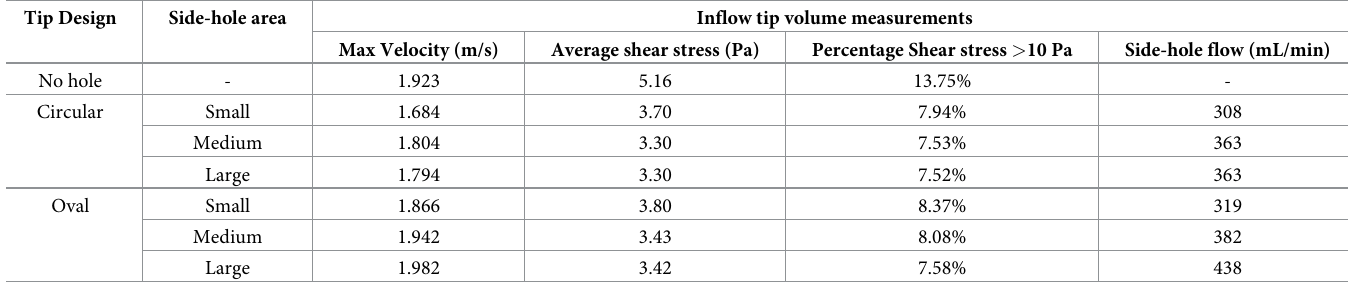
Table 2. Tip volume parameters for the varying sized circular/oval